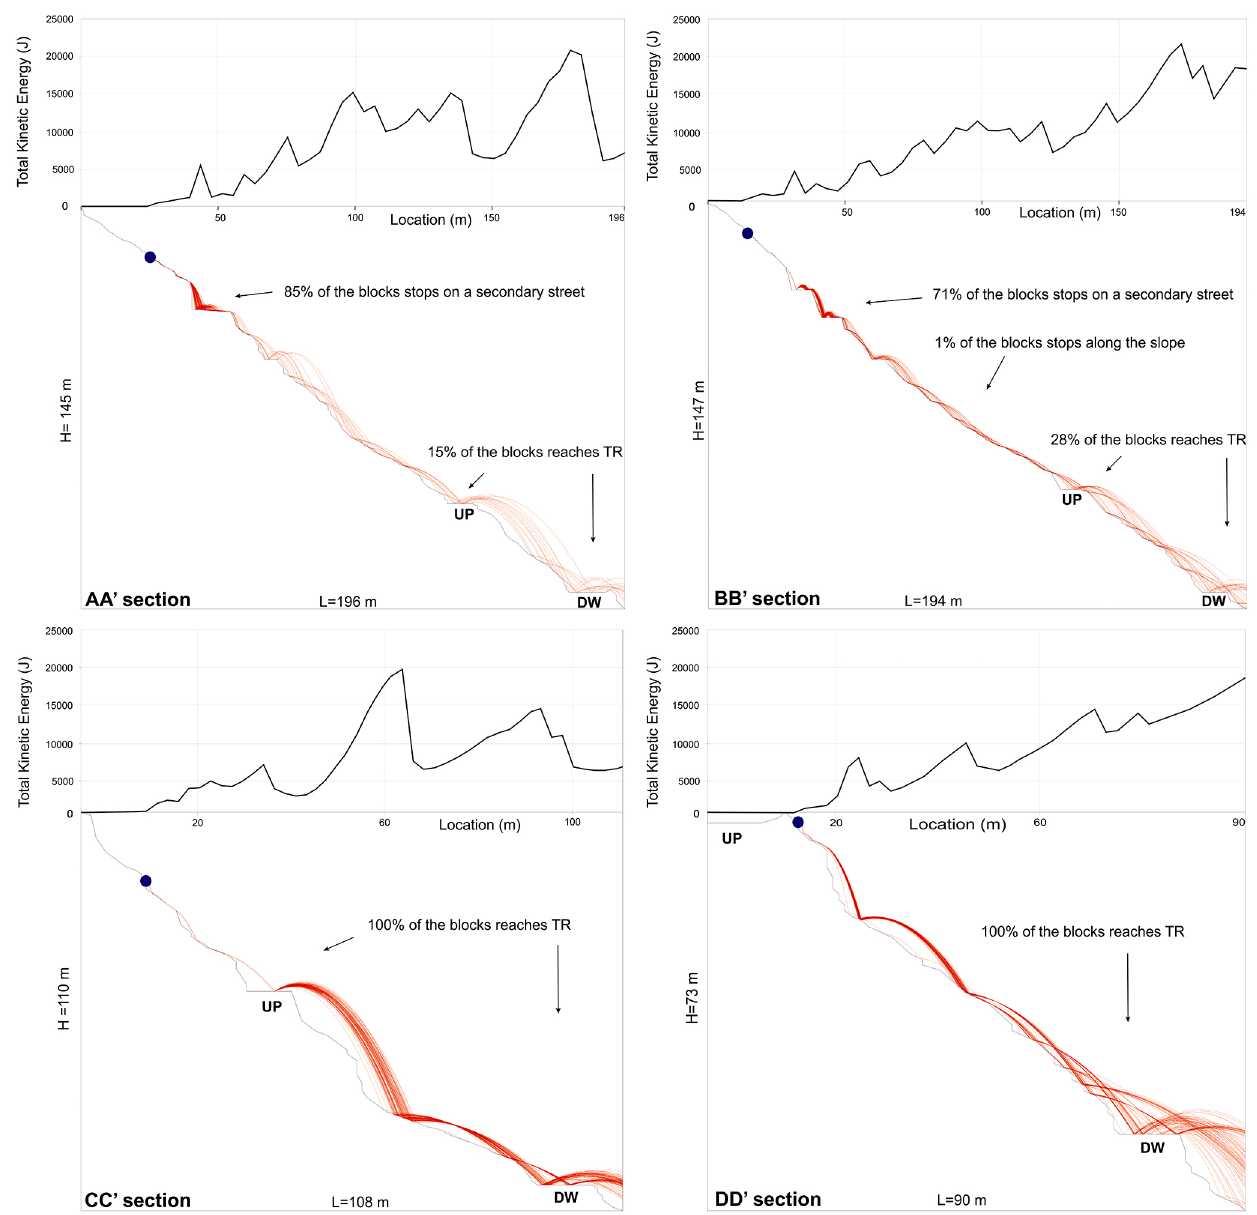
Figure 6. Rockfall simulations and kinetic energy envelope. The blue circles indicate the detachment